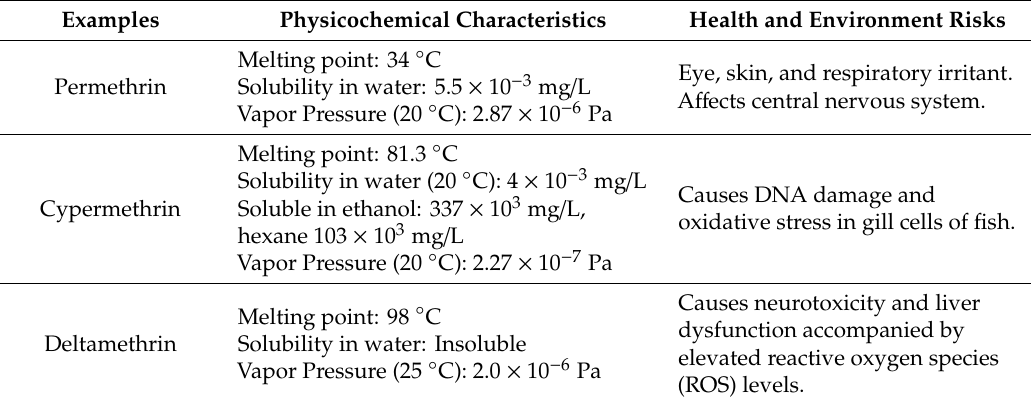
Table 4. Some examples of pyrethrins and pyrethroids pesticides, which are synthesized by duplicating the structure of natural pyrethrins, components of pyrethrum flowers are the optically active esters derived from ( + )- trans -chrysanthemic acid and ( + )- trans -pyrethroic acid